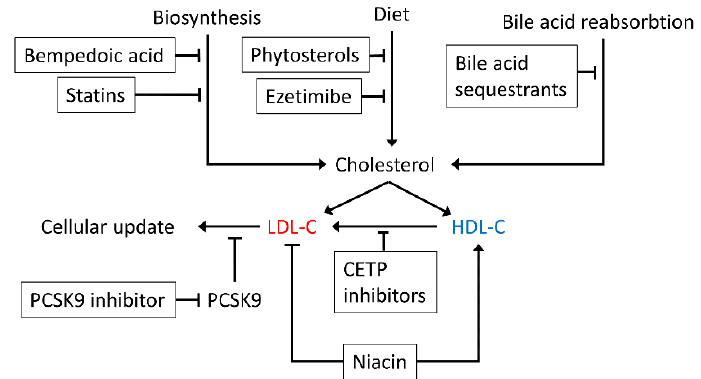
Figure 1. A schematic of the various medications that can be used to lower LDL-C (atherogenic, in red) and raise HDL-C (atheroprotective, in red) and raise HDL-C (atheroprotective, in blue).